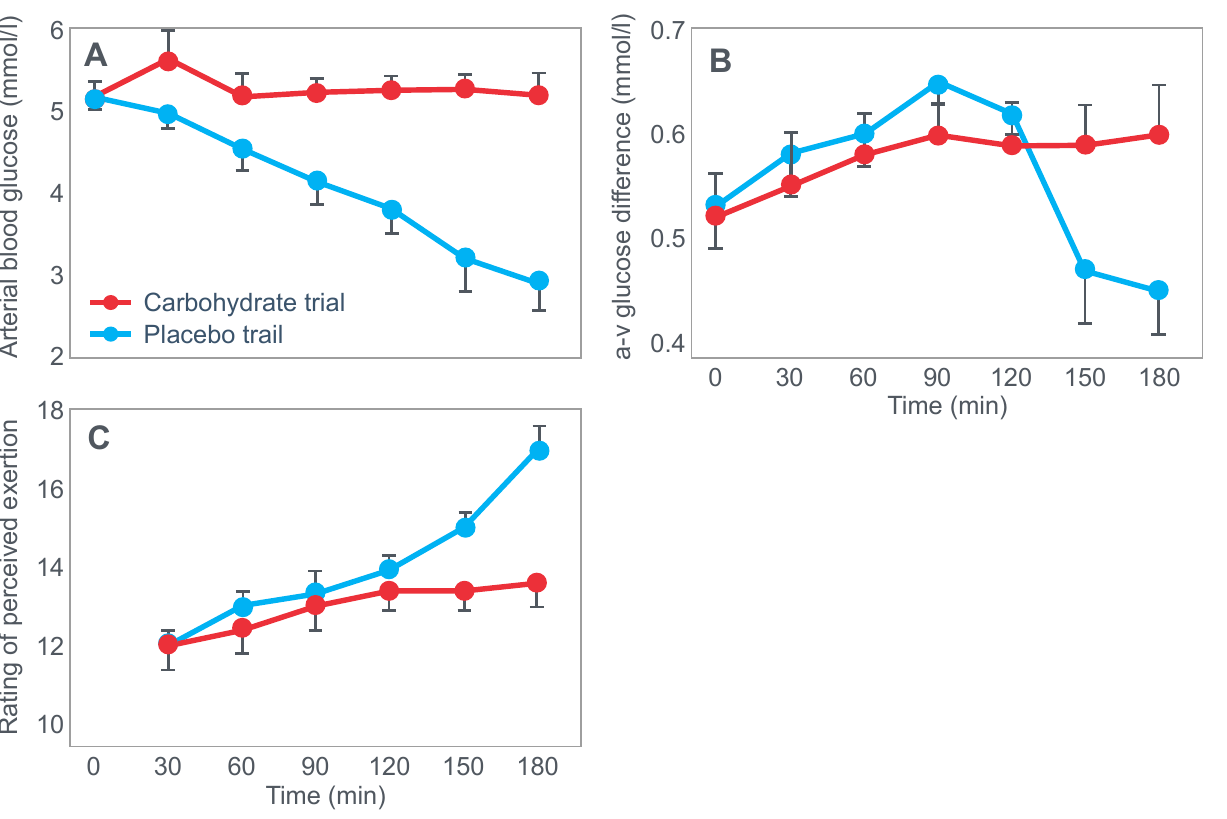
Figure 26. Changes in arterial blood glucose (panel A ) concentrations, arteriovenous glucose differ- ences across the brain (panel B ) and ratings of perceived exertion (panel C ) in subjects when they ingested placebo or glucose during 180 min of exercise. Adapted with permission from ref. [123]. Copy-right 2003 Acta Physiologica (John Wiley and Sons).